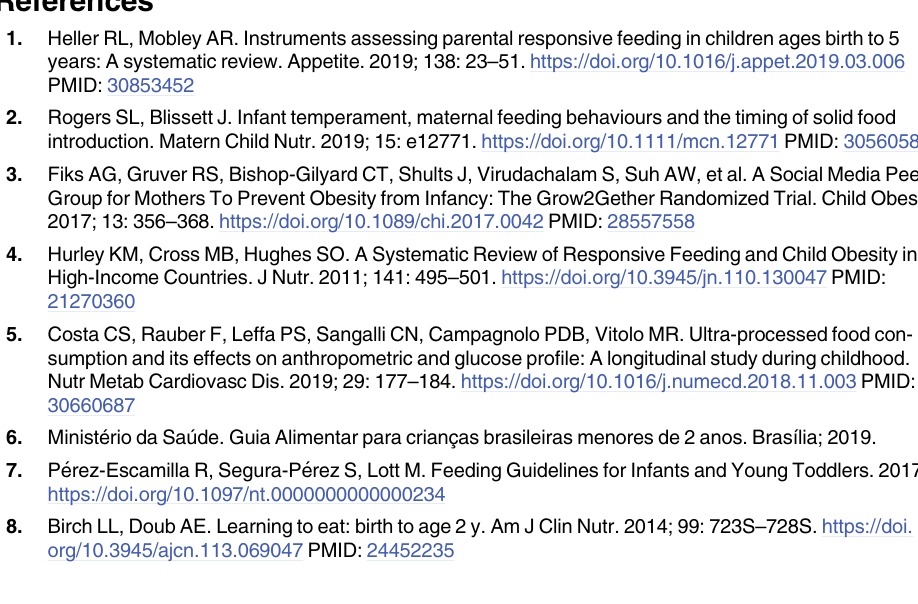
S1 Table. Results of the steps for the cross-cultural adaptation of the Infant Feeding Style Questionnaire (IFSQ-Br). Federal District, Brazil.